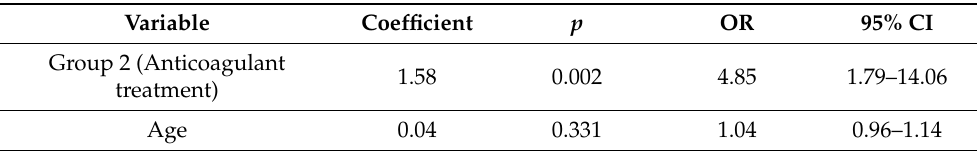
Table 3. Coefficients of the logistic regression model that characterize the probability that a patient with NAEH at D&C will be diagnosed with more advanced lesions after hysterectomy, in relation with age and history of